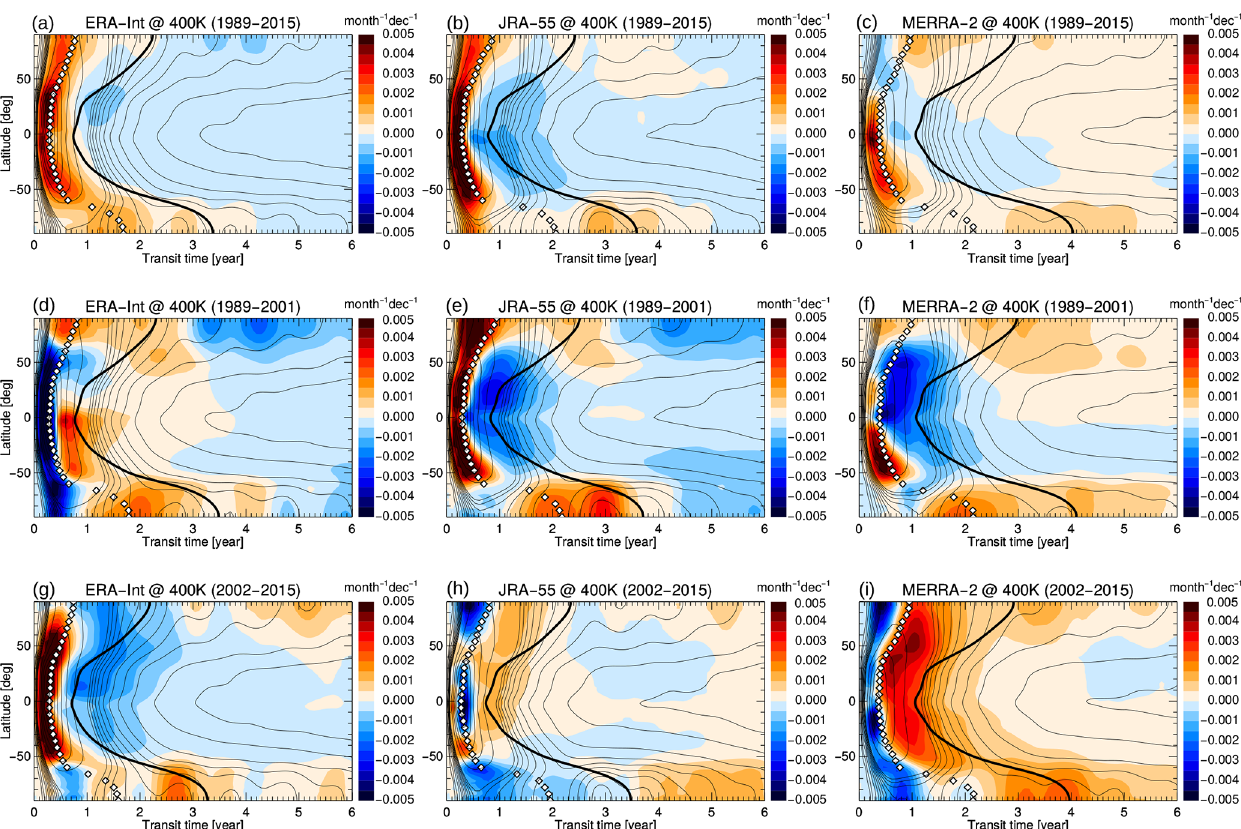
Figure 8. Age spectrum trend (annual mean) at 400K for ERA-Interim (a, d, g) , JRA-55 (b, e, h) and MERRA-2 (c, f, i) , and for the periods 1989–2015 (a, b, c) , 1989–2001 (d, e, f) , and 2002–2015 (g, h, i) . The thin black contours show the climatological age spectrum, the thick black line shows the climatological mean age, and the white diamonds show the climatological modal